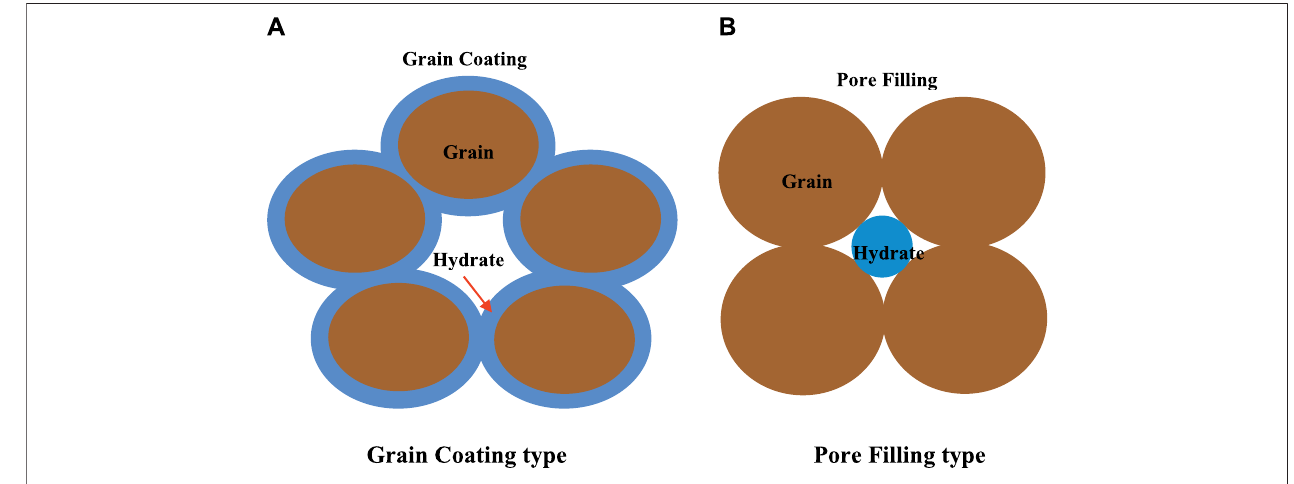
FIGURE 5 | The schematic of main hydrate morphology in porous